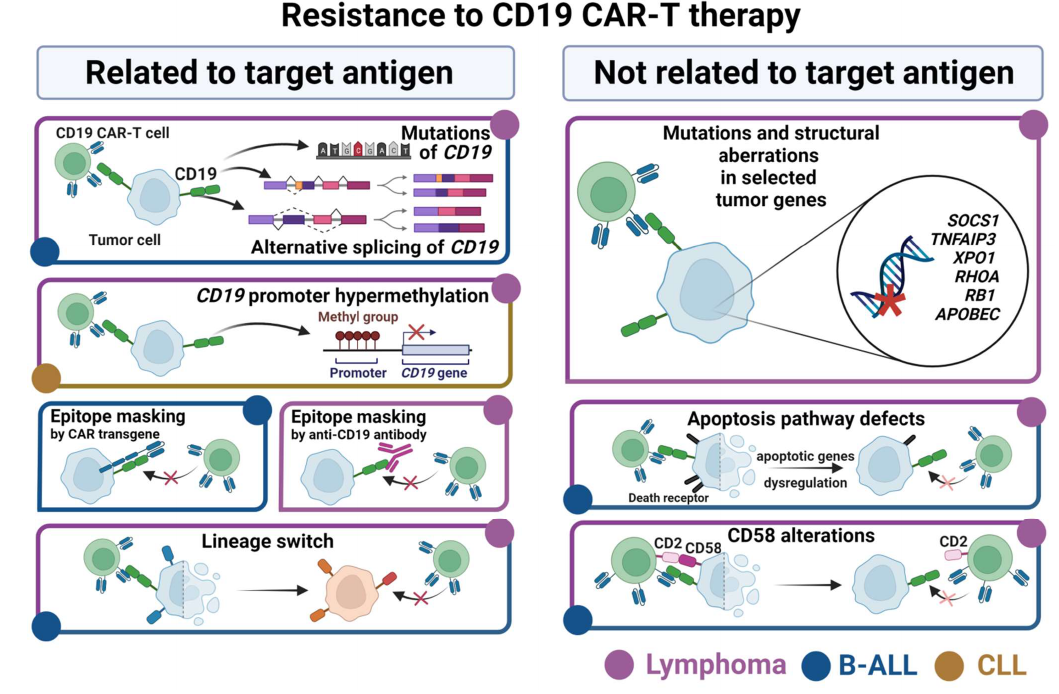
Figure 1. B cell-derived cancers develop various mechanisms of resistance to CD19 CAR-T therapy. Left panel: the mechanisms related to downregulation of target antigen include genetic and epigenetic aberrations within CD19 gene or alternative splicing of CD19 transcripts. Another possibility of resistance development is CD19 epitope masking by either a CD19-specific CAR construct, or therapeutic anti-CD19 antibody. Target antigen loss can also occur as a consequence of phenotypic changes due to the lineage switch of malignant B cell precursors. Right panel: target antigen-independent mechanisms of resistance cover structural aberrations and mutations in selected genes of malignant lymphoma cells. Additionally, disruption of the apoptosis pathway or CD58-CD2 co-stimulation could be involved in this